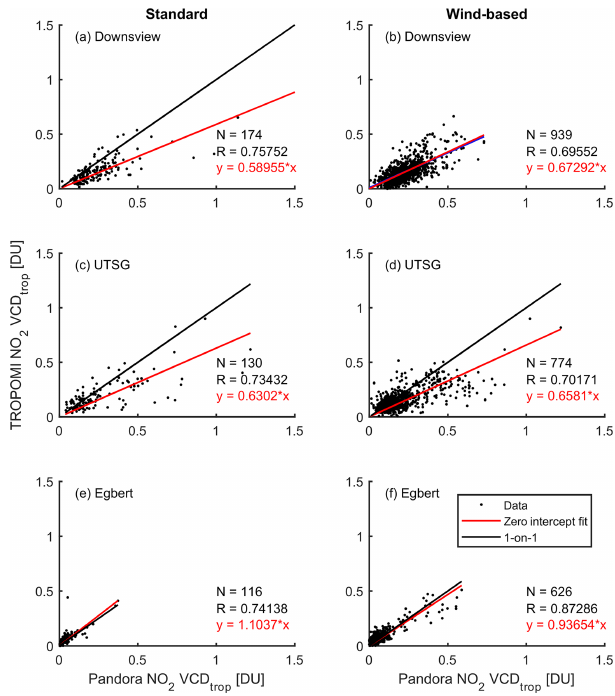
Figure C2. TROPOMI KNMI NO 2 VCD trop vs. Pandora NO 2 VCD trop .